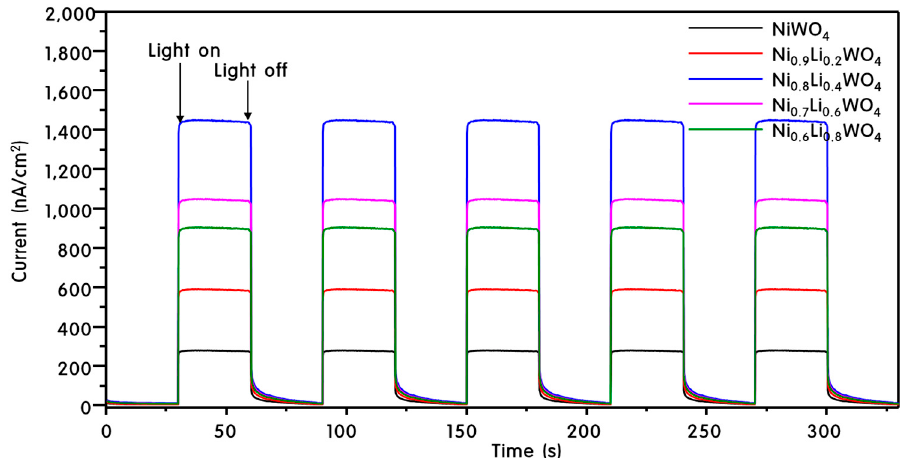
Figure 7. Photocurrent responses of Ni 1-x Li 2x WO 4 particles.